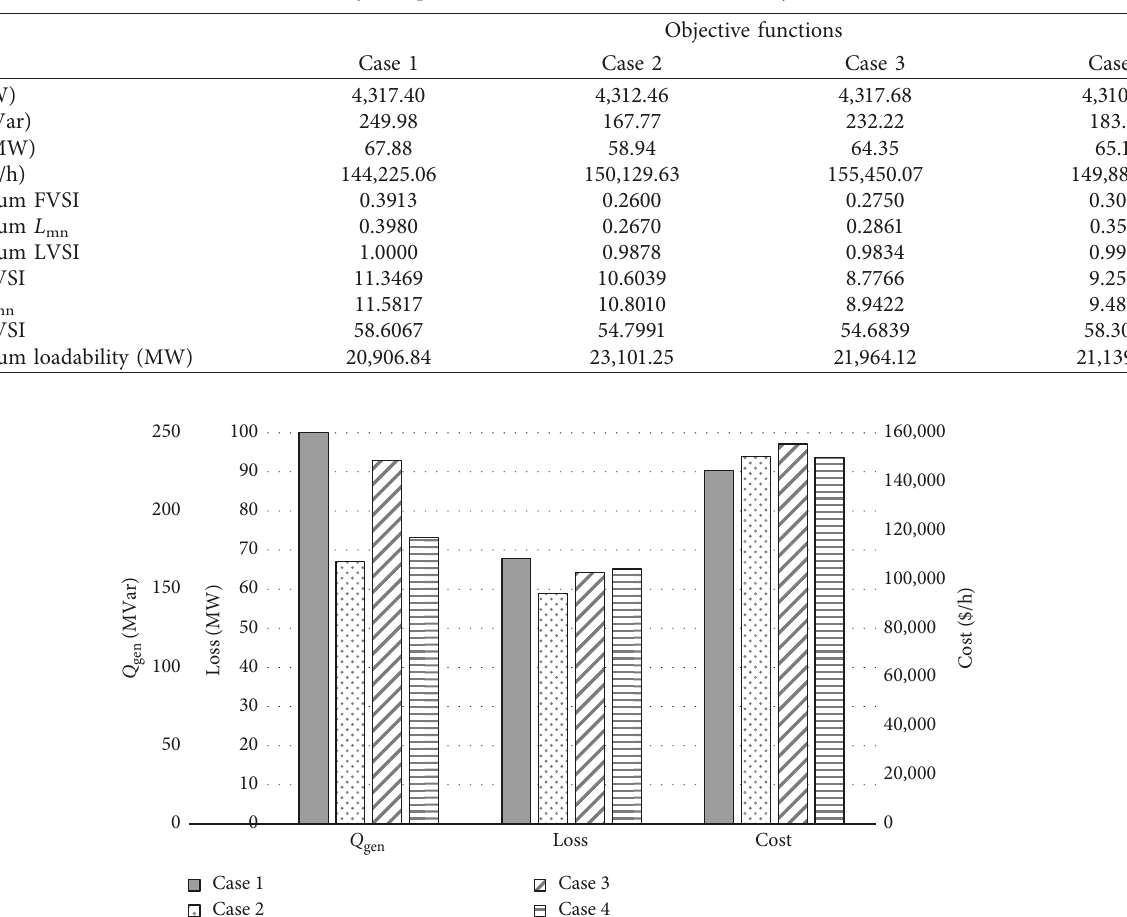
Figure 4: Variable comparisons for the IEEE 57-bus test system. Table 3: System performance of the IEEE 118-bus test system.